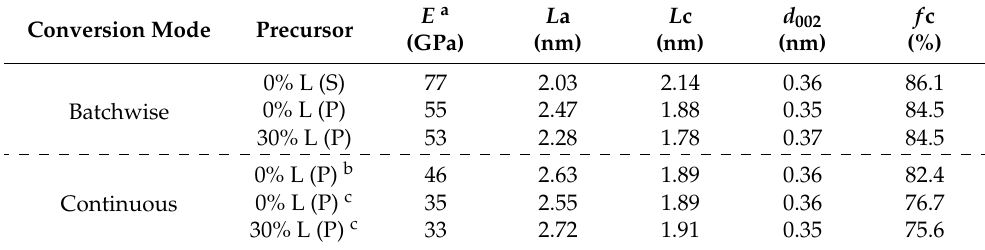
Table 4. Structural parameters and orientation from WAXS of CFs prepared by batchwise and continuous conversion. L = Lignin; S = System S; P = System